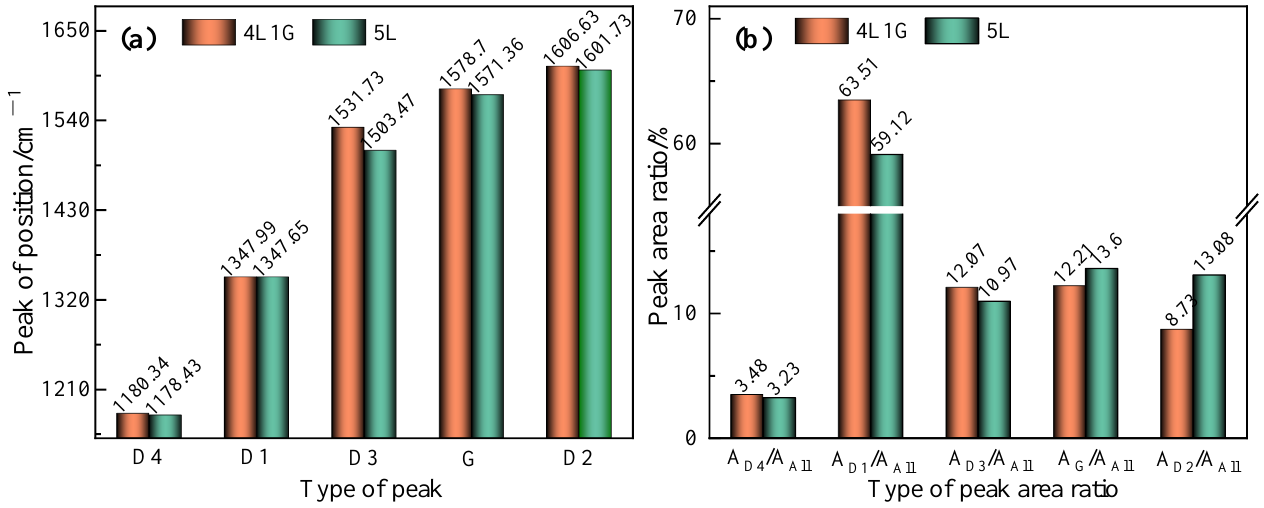
Figure 2. Peak positions ( a ) and peak area ratios ( b ) obtained by different fitting methods.